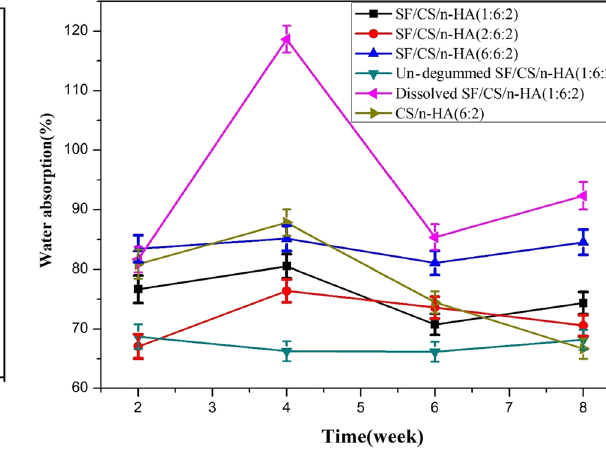
Figure 3: Tensile strengths of the composite membranes: ( a ) CS/n - HA ( 6:2 ) , ( b ) SF/CS/n - HA ( 1:6:2 ) , ( c ) SF/CS/n - HA ( 2:6:2 ) , ( d ) SF/CS/n - HA ( 6:6:2 ) , ( e ) un - degummed SF/CS/n - HA ( 1:6:2 ) , and ( f ) dissolved SF/CS/n - HA ( 1:6:2 ) .